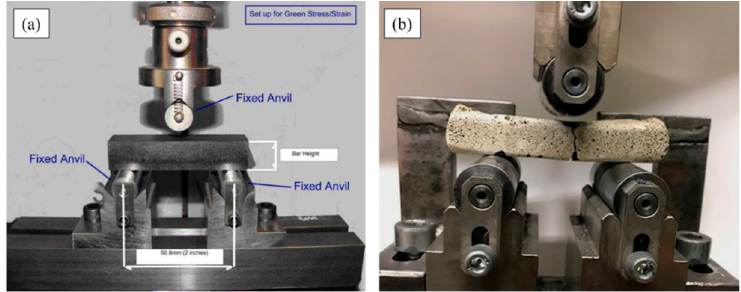
Figure 8. Images of stand with the reference sample used for testing the flexural strength ( a ) and cracked sample of as-dried Thermacoat™ with 0.7 % of polypropylene fibers ( b ). It was connected with the recurrent nucleation and propagation of cracks developing under the progressive down-movement of the anvil pressing against the tested sample.